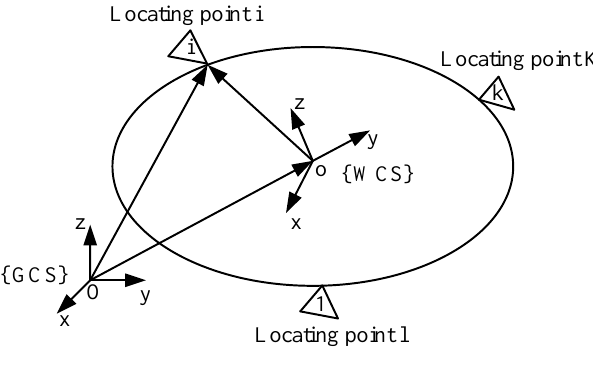
Figure 8. Location model.